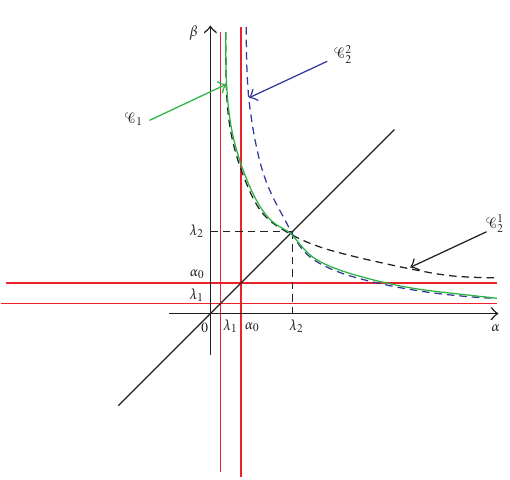
Figure 6.1 . The first curve in the Fuˇcik